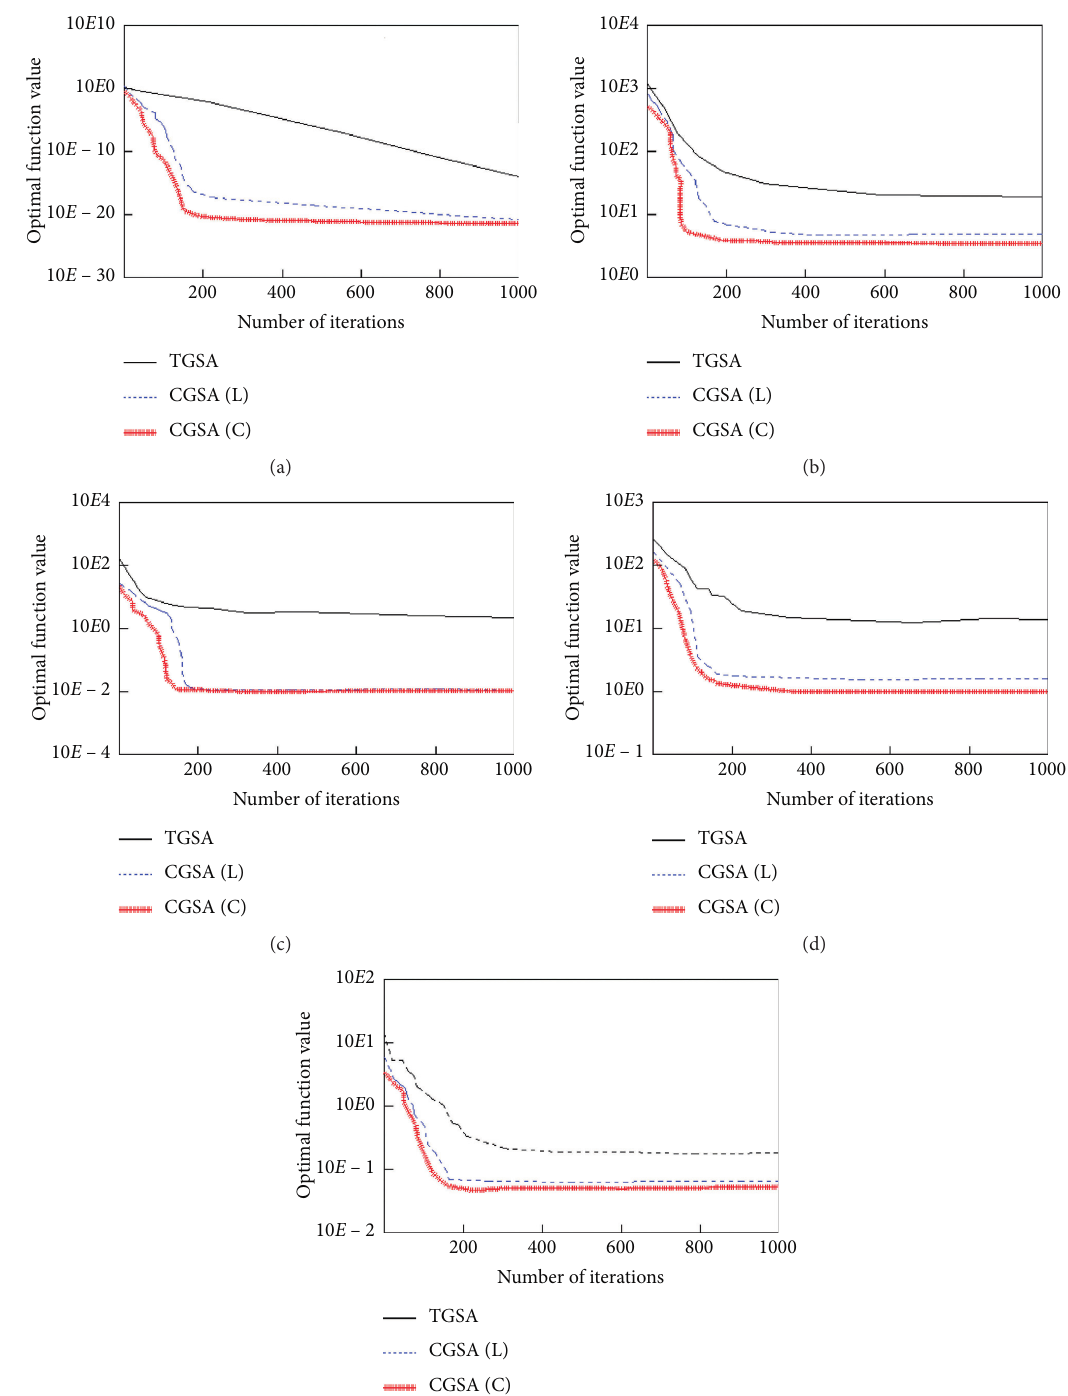
Figure 3: Convergence curves of different functions. (a) f ( x ) convergence curves. (e) f curves. (d) f 4